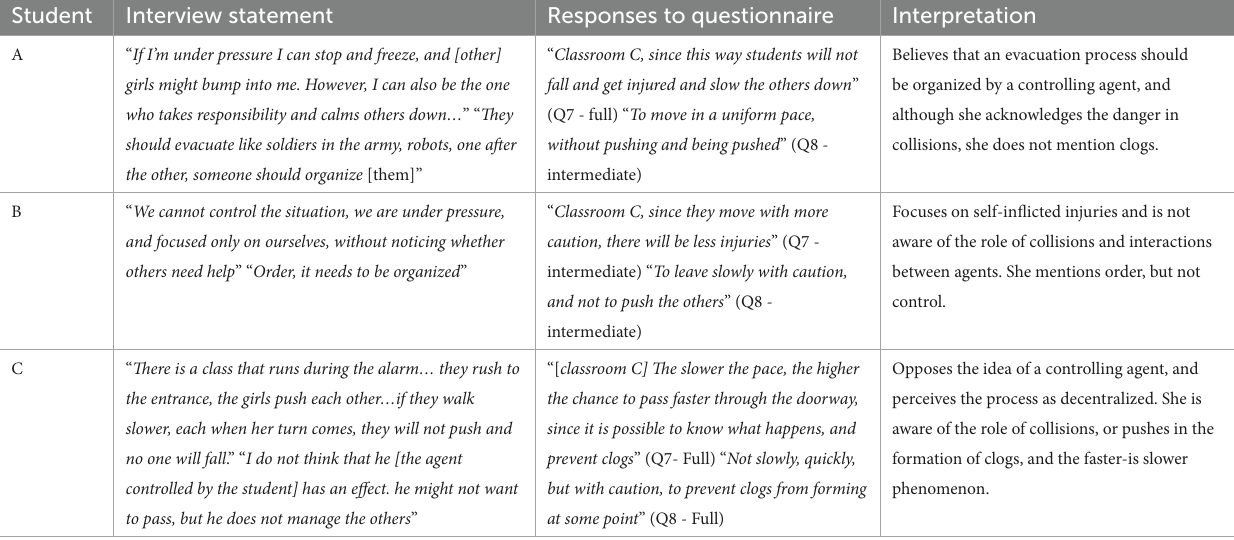
TABLE 3 Student utterances in the interviews, their interpretations, and their open-ended question responses.